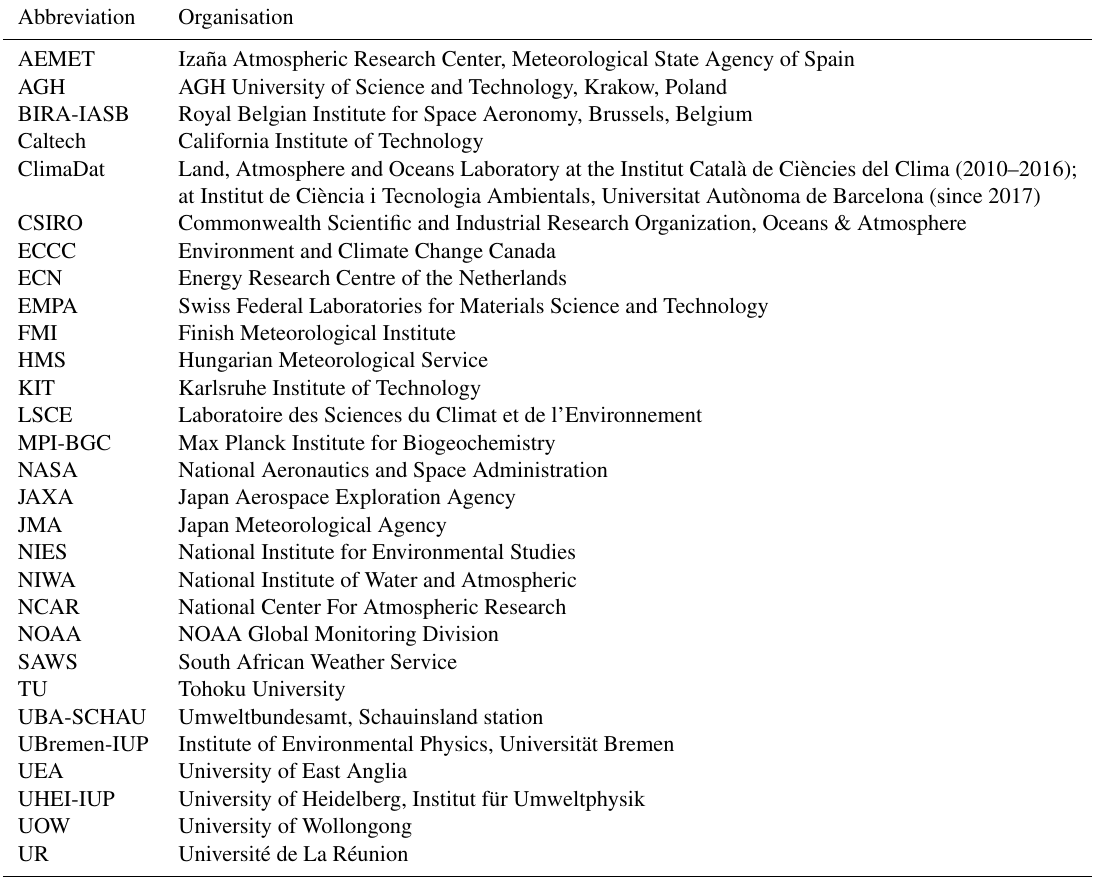
Table A2. Organisations associated with observing